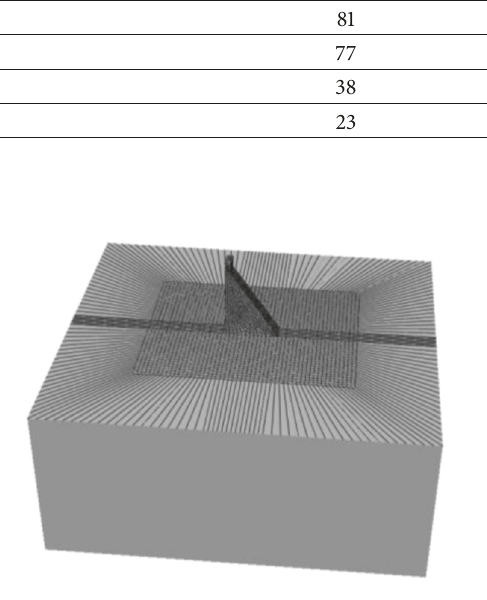
Figure 19: Finite-infinite element coupling model of the dam foundation